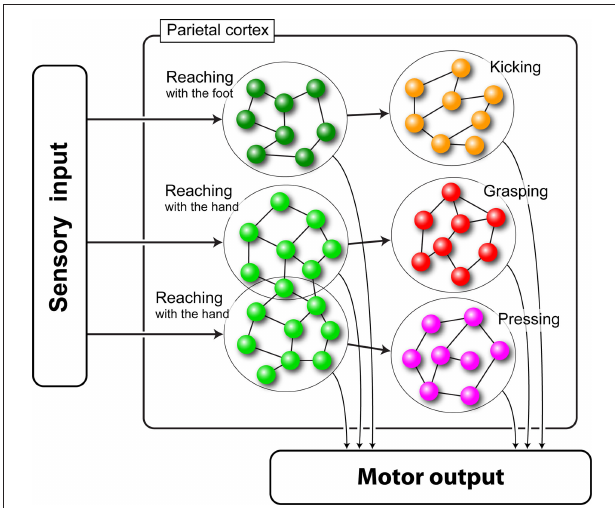
Figure 2 | Schematic representation of the chained organization of the network. Each large circle represents a pool of neurons (small spheres) encoding a specific motor act. Lines represent the connections between neurons. Lines on the left represent external inputs that start the